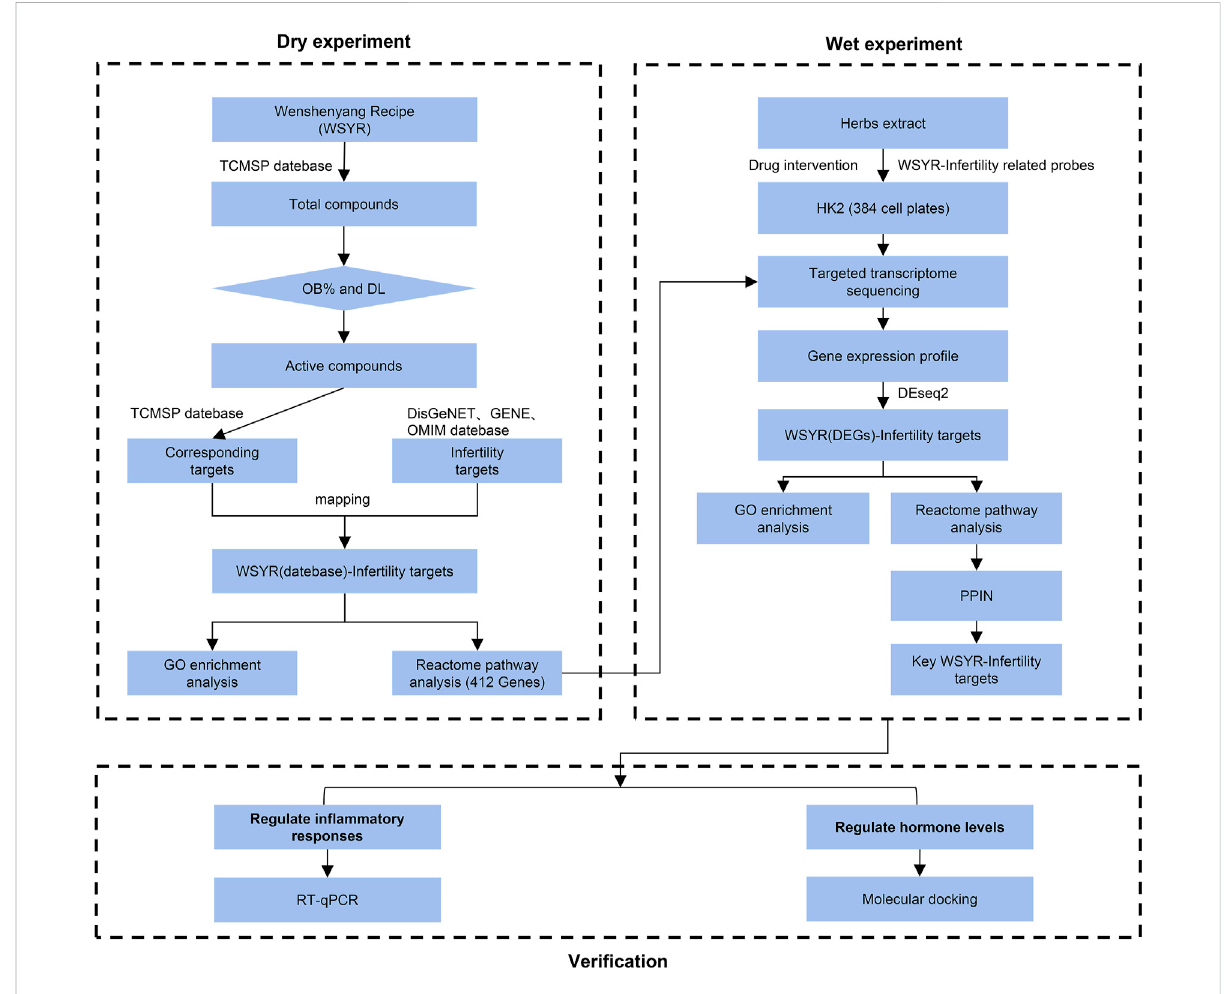
FIGURE 1 Experimental technical